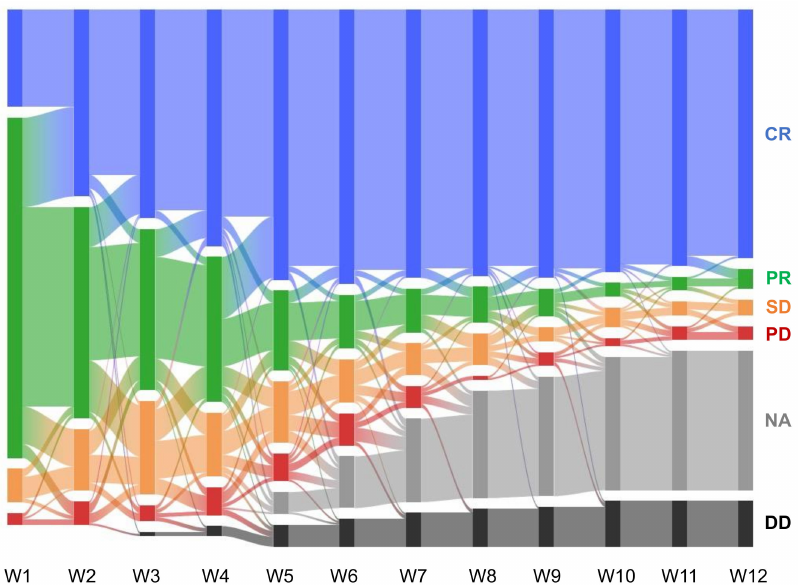
Figure 2. Dynamic changes in the clinical outcomes of the patient cohort during the first 12 weeks of the (L-)CHOP chemotherapy. CR, PR, SD, and PD denote clinical remission, partial response, stable disease, and progressive disease reported by the vets. “NA” represents the cases where the patients were no longer treated with the (L-)CHOP chemotherapy, while “DD” (dead) includes the cases where the patients were